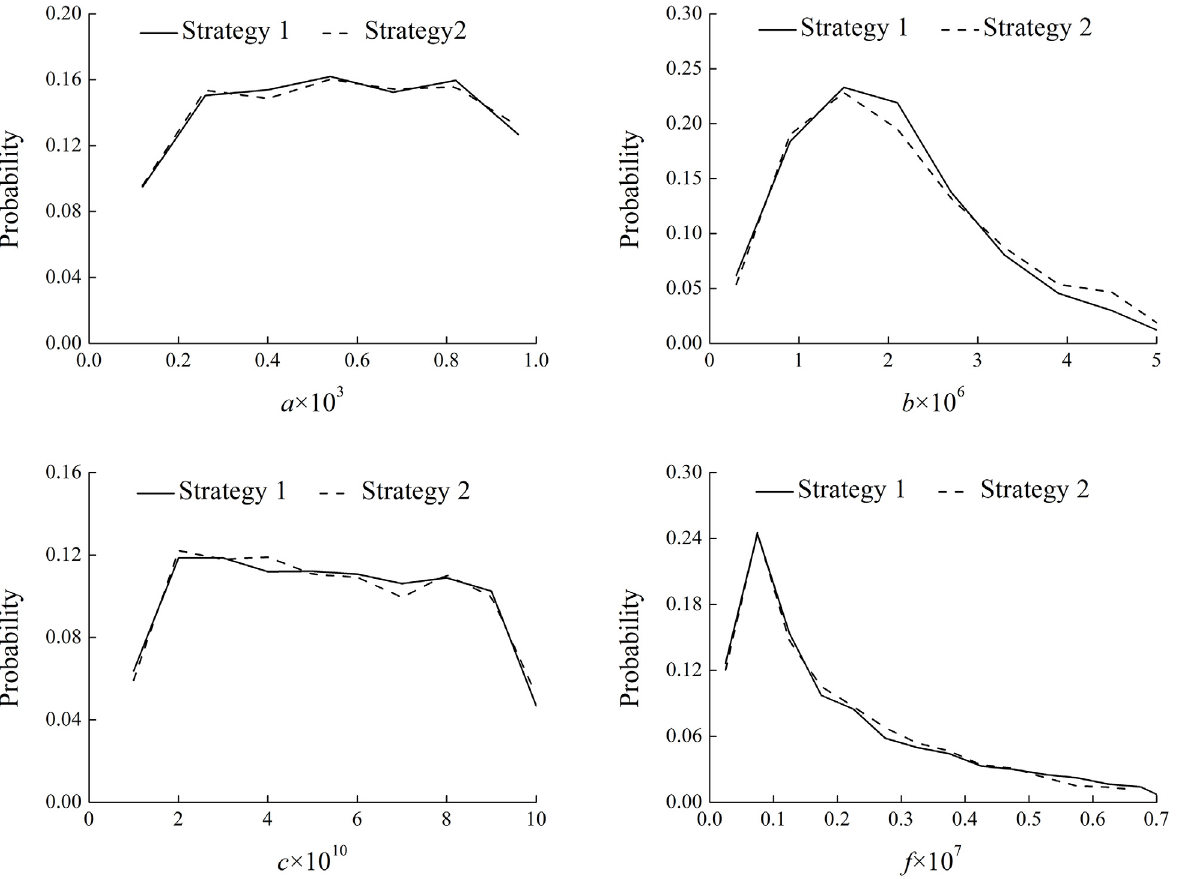
Fig 3. Posterior probability distributions of the behavior-giving parameters with Strategy 1 and